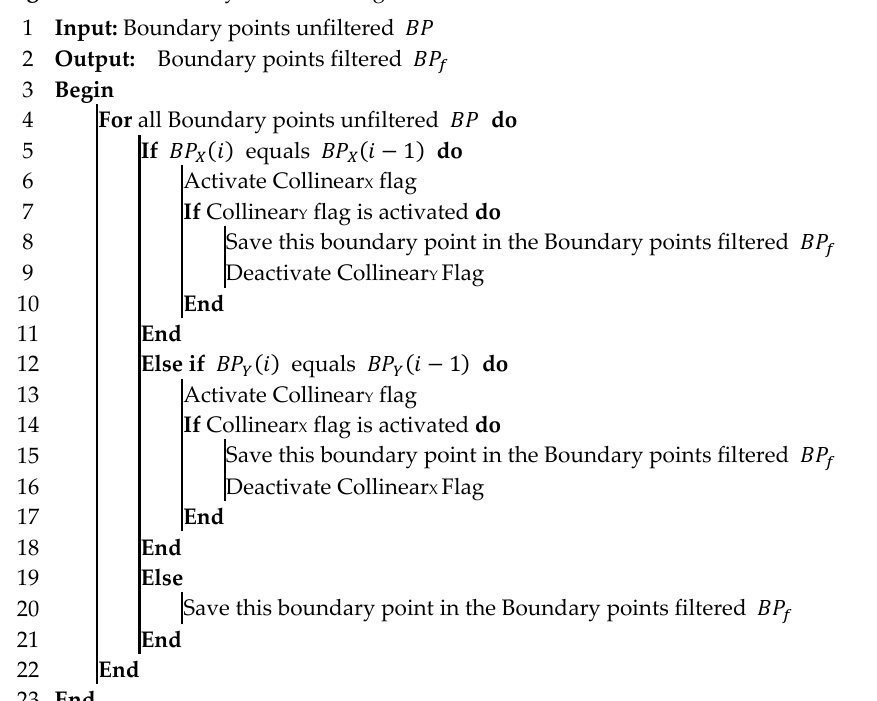
Algorithm 2: Boundary Point Filtering